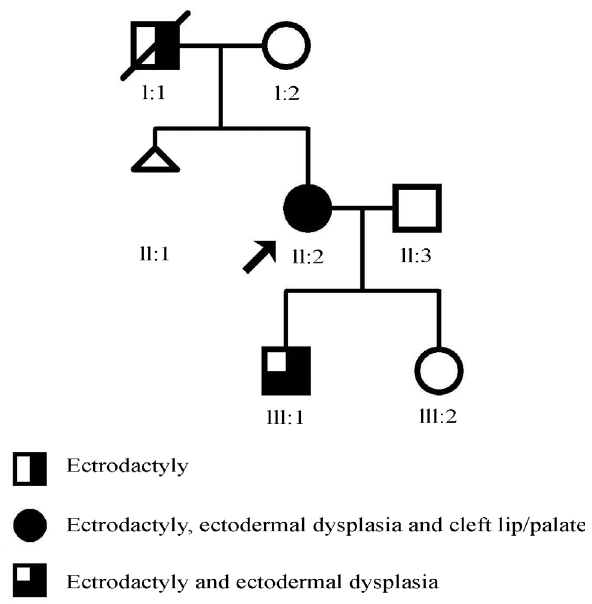
Figure 1 - Pedigree of family with ectrodactyly-ectodermal dysplasia and cleft lip/palate (EEC)